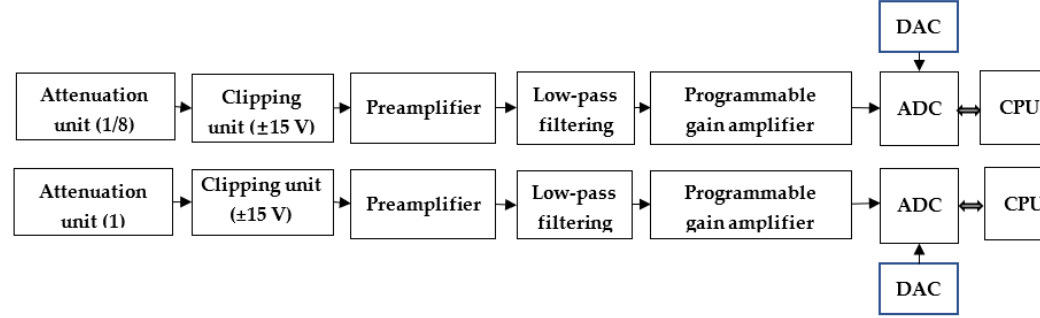
Figure 14. Data acquisition diagram.